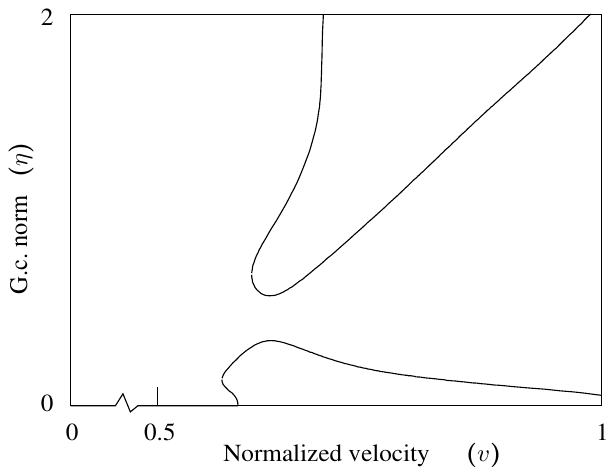
Figure 2. Typical limit-cycle oscillation (LCO) plot from a V - ω - η analysis.